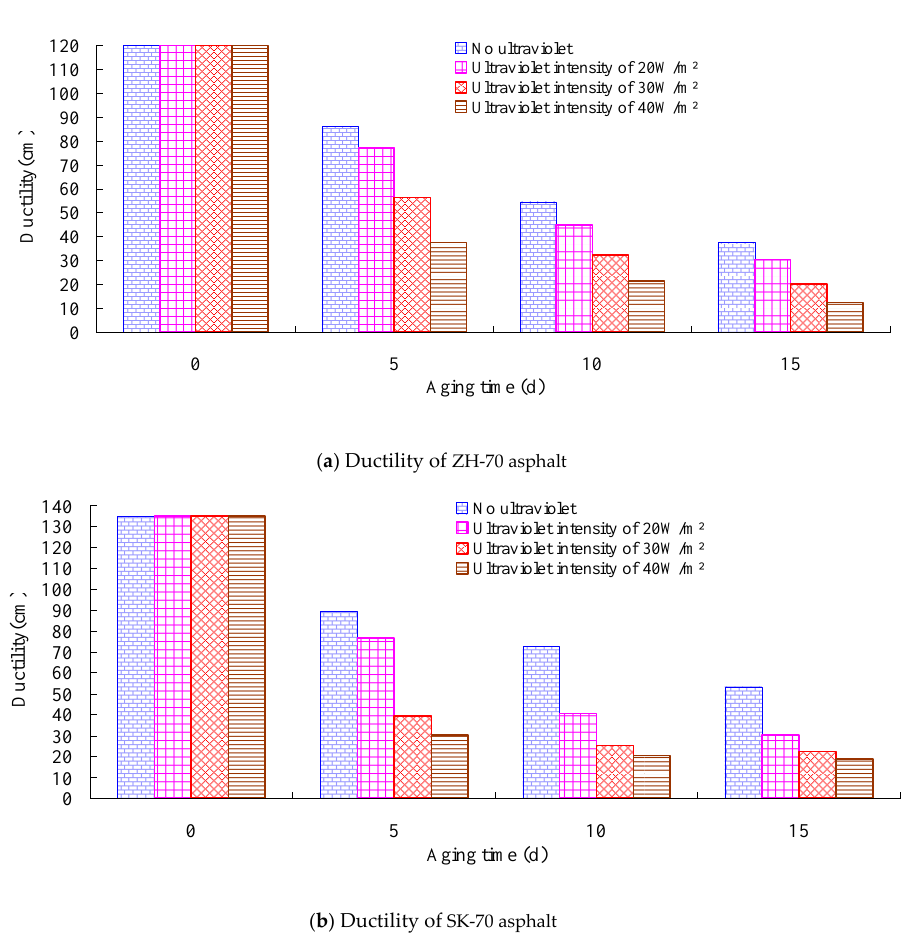
Figure 4. Relationship between ductility and aging time for different UV intensity.